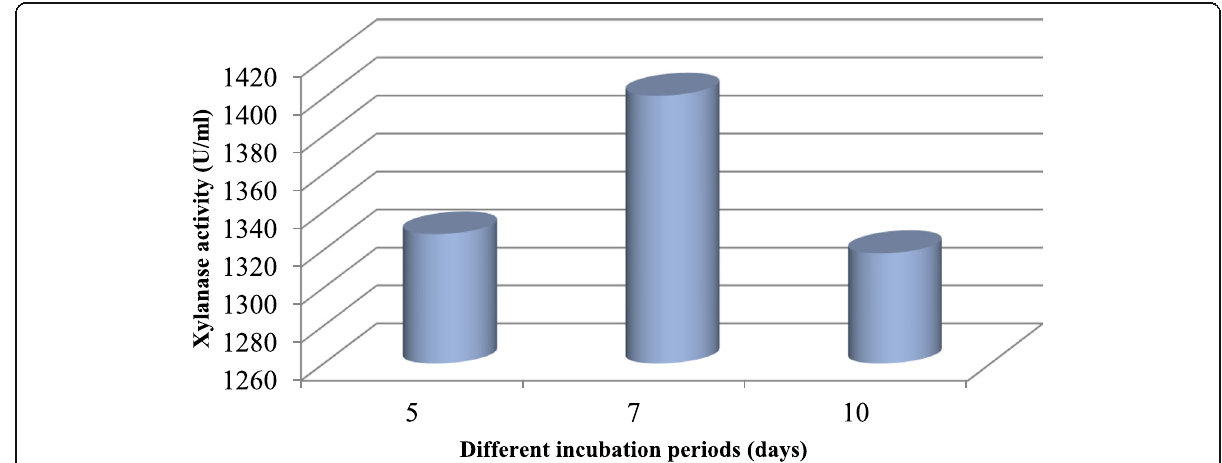
Fig. 4 Effect of different incubation periods (days) on xylanase